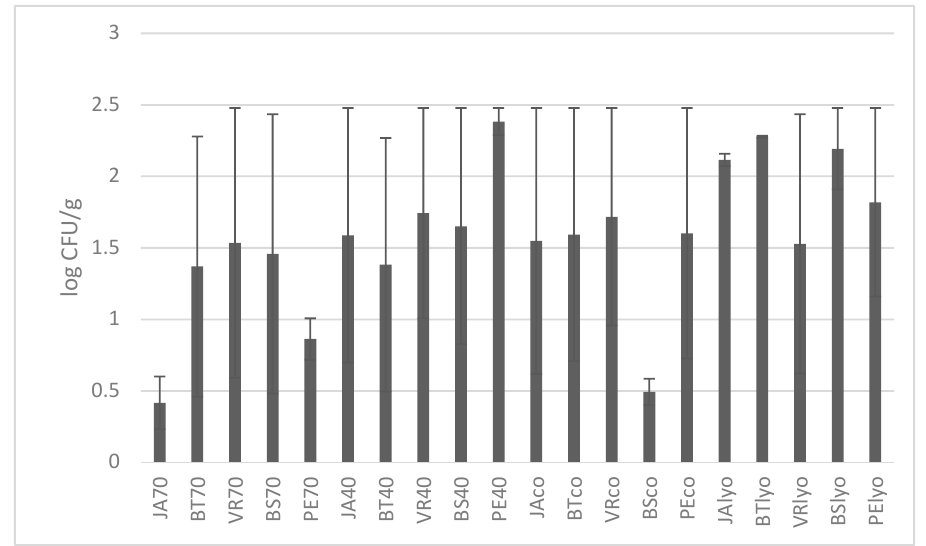
Figure 4. Determination of total count of microorganisms (TCM) in individual varieties depending on drying methods (70 °C, 40 °C, combined, lyophilised) in log CFU/g. Varieties: JA—Jakubské, BT—Beauty seedless, PE—Perlette, VR—Vrboska, BS—Bezsemenné. CFU—colony forming units.